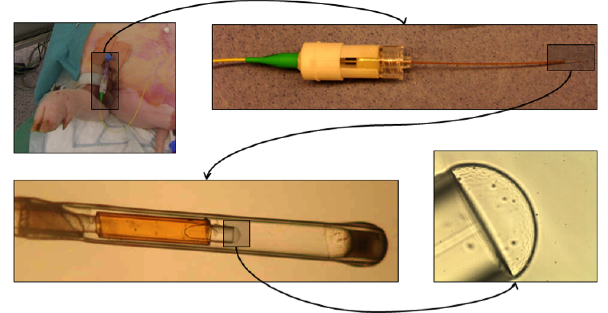
Figure 1: The GlucoSet sensor (Tierney et al., 2009; Skjærvold et al., 2012).